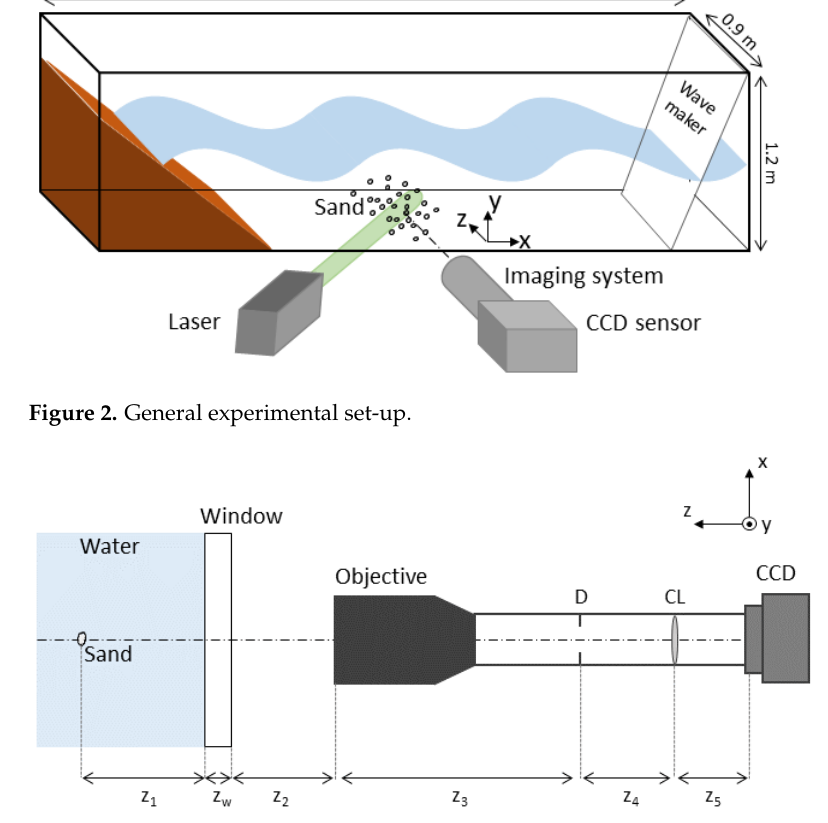
Figure 3. Experimental imaging set-up.